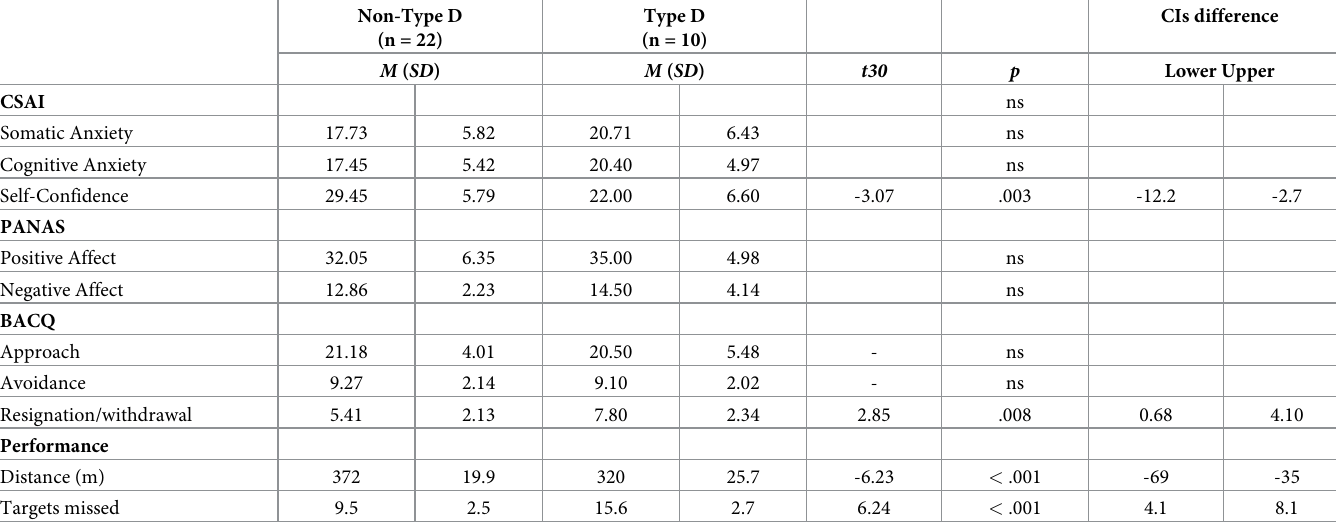
Table 4. Mean and standard deviations and statistical result for the dependent variables of study